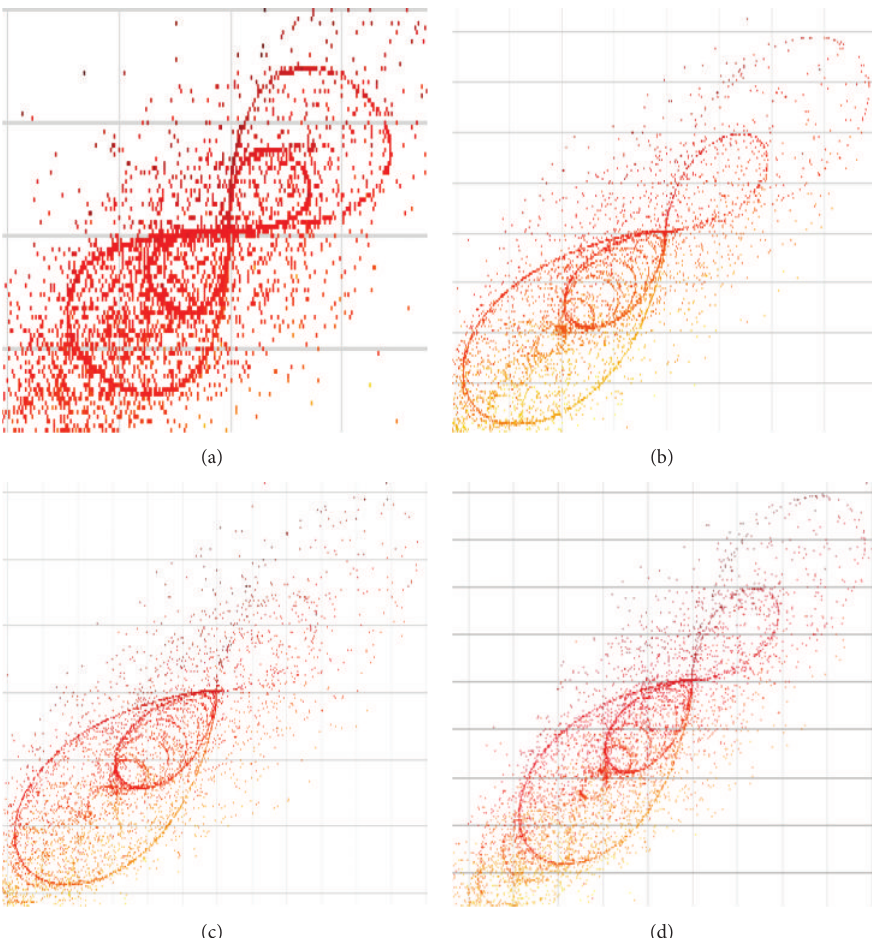
Figure 8: (a) 𝑅 = 1.4 , heating rate of 5 K/min, (b) 𝑅 = 1.4 , heating rate of 10K/min, (c) 𝑅 = 1.4 , heating rate of 15K/min, and (d) 𝑅 = 1.4 , heating rate of 20 K/min. (The horizontal axis and vertical axis is, respectively, 𝑥(𝑡) -DTG and 𝑥(𝑡 + 1) -DTG, the colour as